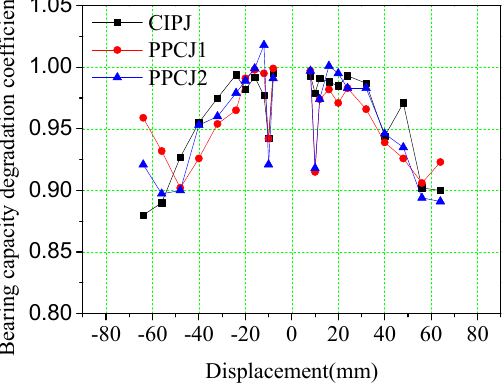
Figure 21. Bearing capacity degradation coefficient for right beam of joint.